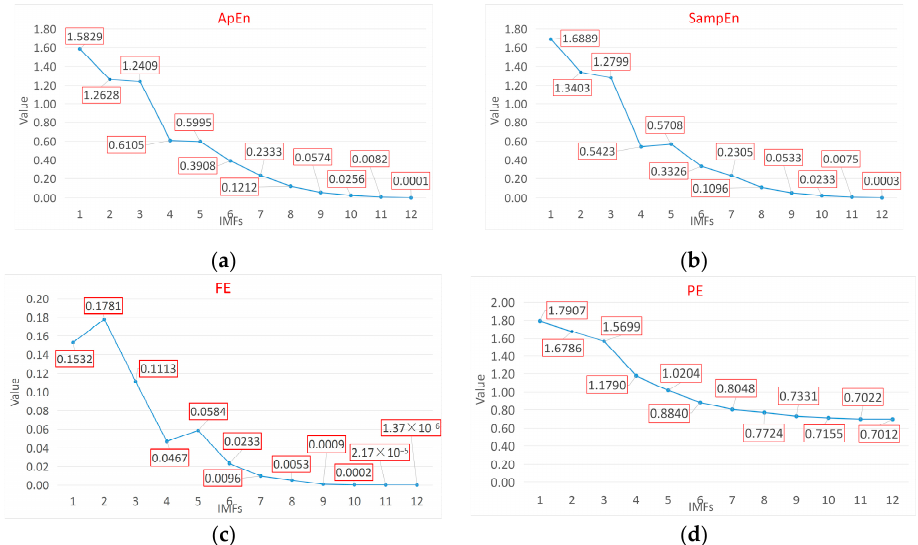
Figure 10. IMFs of actual micro-seismic data.